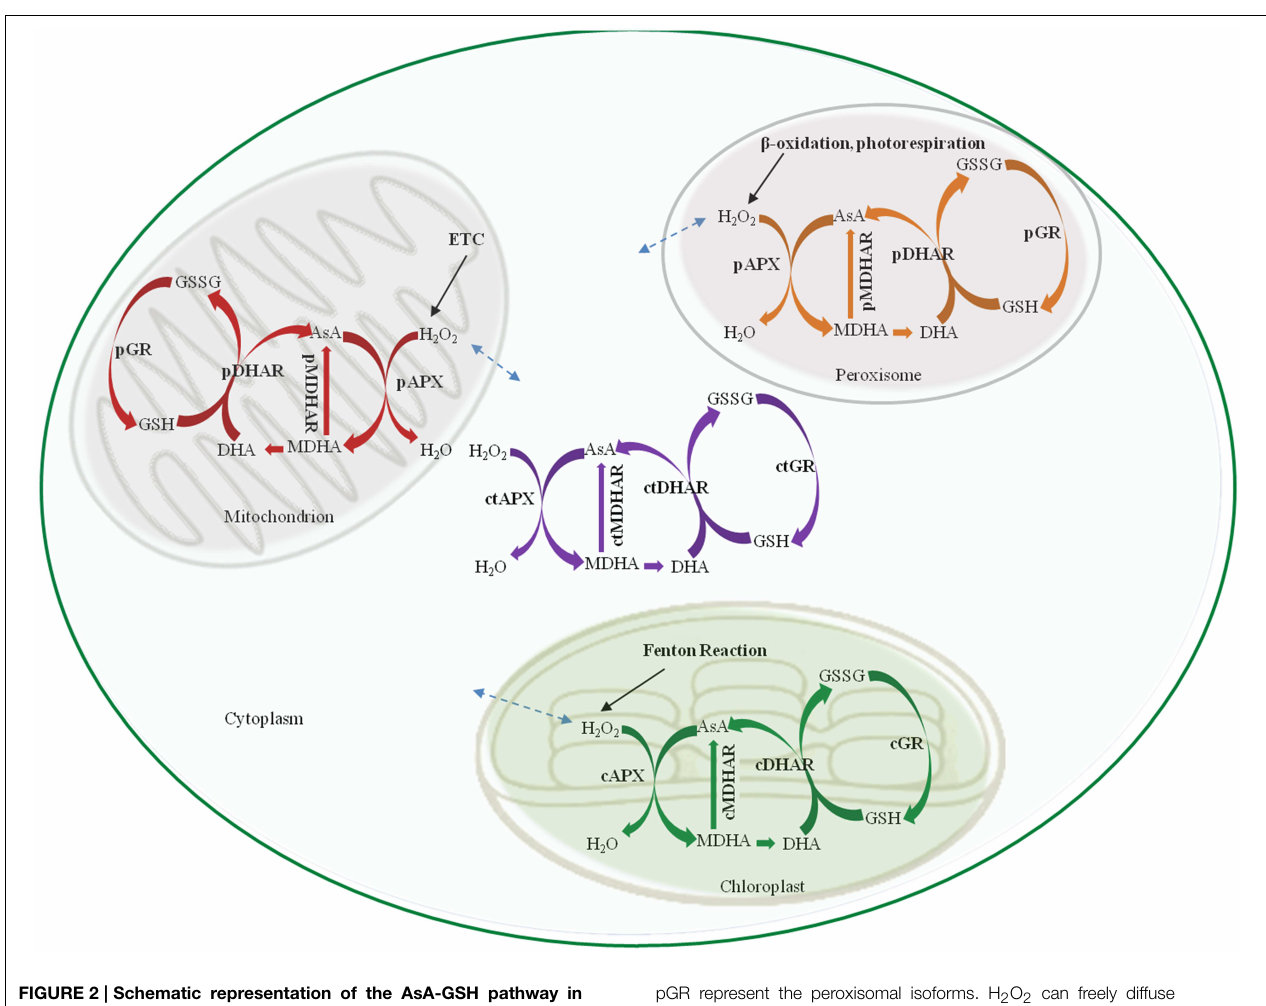
FIGURE 2 | Schematic representation of the AsA-GSH pathway in different sub-cellular compartments. cAPX, cMDHAR, cDHAR, and cGR represent the chloroplastic isoforms; ctAPX, ctMDHAR, ctDHAR, and ctGR stand for the cytoplasmic, mAPX, mDHAR, and mGR indicate the mitochondrial isoforms and pAPX, pMDHAR, pDHAR, and